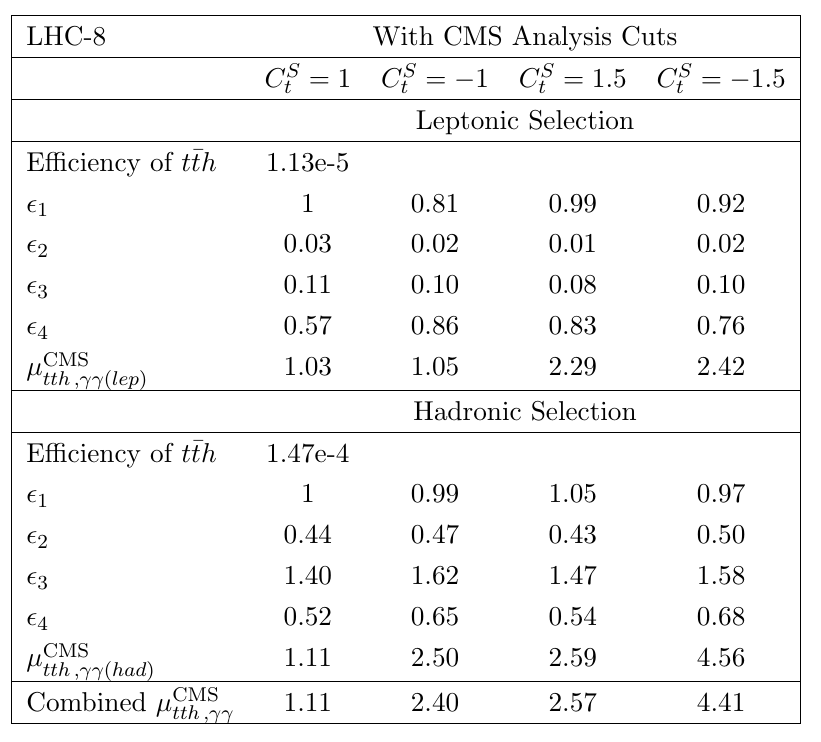
Table 7 . Category (cid:13)(cid:13) : the D -dependent detection e(cid:14)ciency ratios (cid:15) i ’s de(cid:12)ned in eq. (2.10) with p the CMS cuts for the category (cid:13)(cid:13) taking C S = (cid:6) 1 ; (cid:6) 1 : 5 and s = 8 TeV. The resulting signal t strengths (cid:22) CMS and (cid:22) CMS are also shown. Note that the CMS cuts N ( j ) (cid:21) 4 ; N ( b ) (cid:21) 1 tth;(cid:13)(cid:13) ( lep ) tth;(cid:13)(cid:13) ( had ) for (cid:13)(cid:13) hadronic channel are not strong enough to separate t (cid:22) th from thX processes.